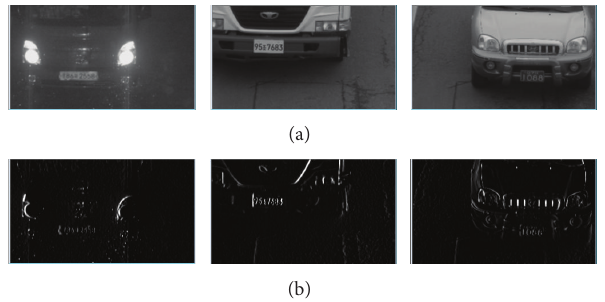
Figure 13: Results of image preprocessing: (a) examples of filtered image after using Gaussian filter and (b) examples of edge image after using Sobel vertical operator.